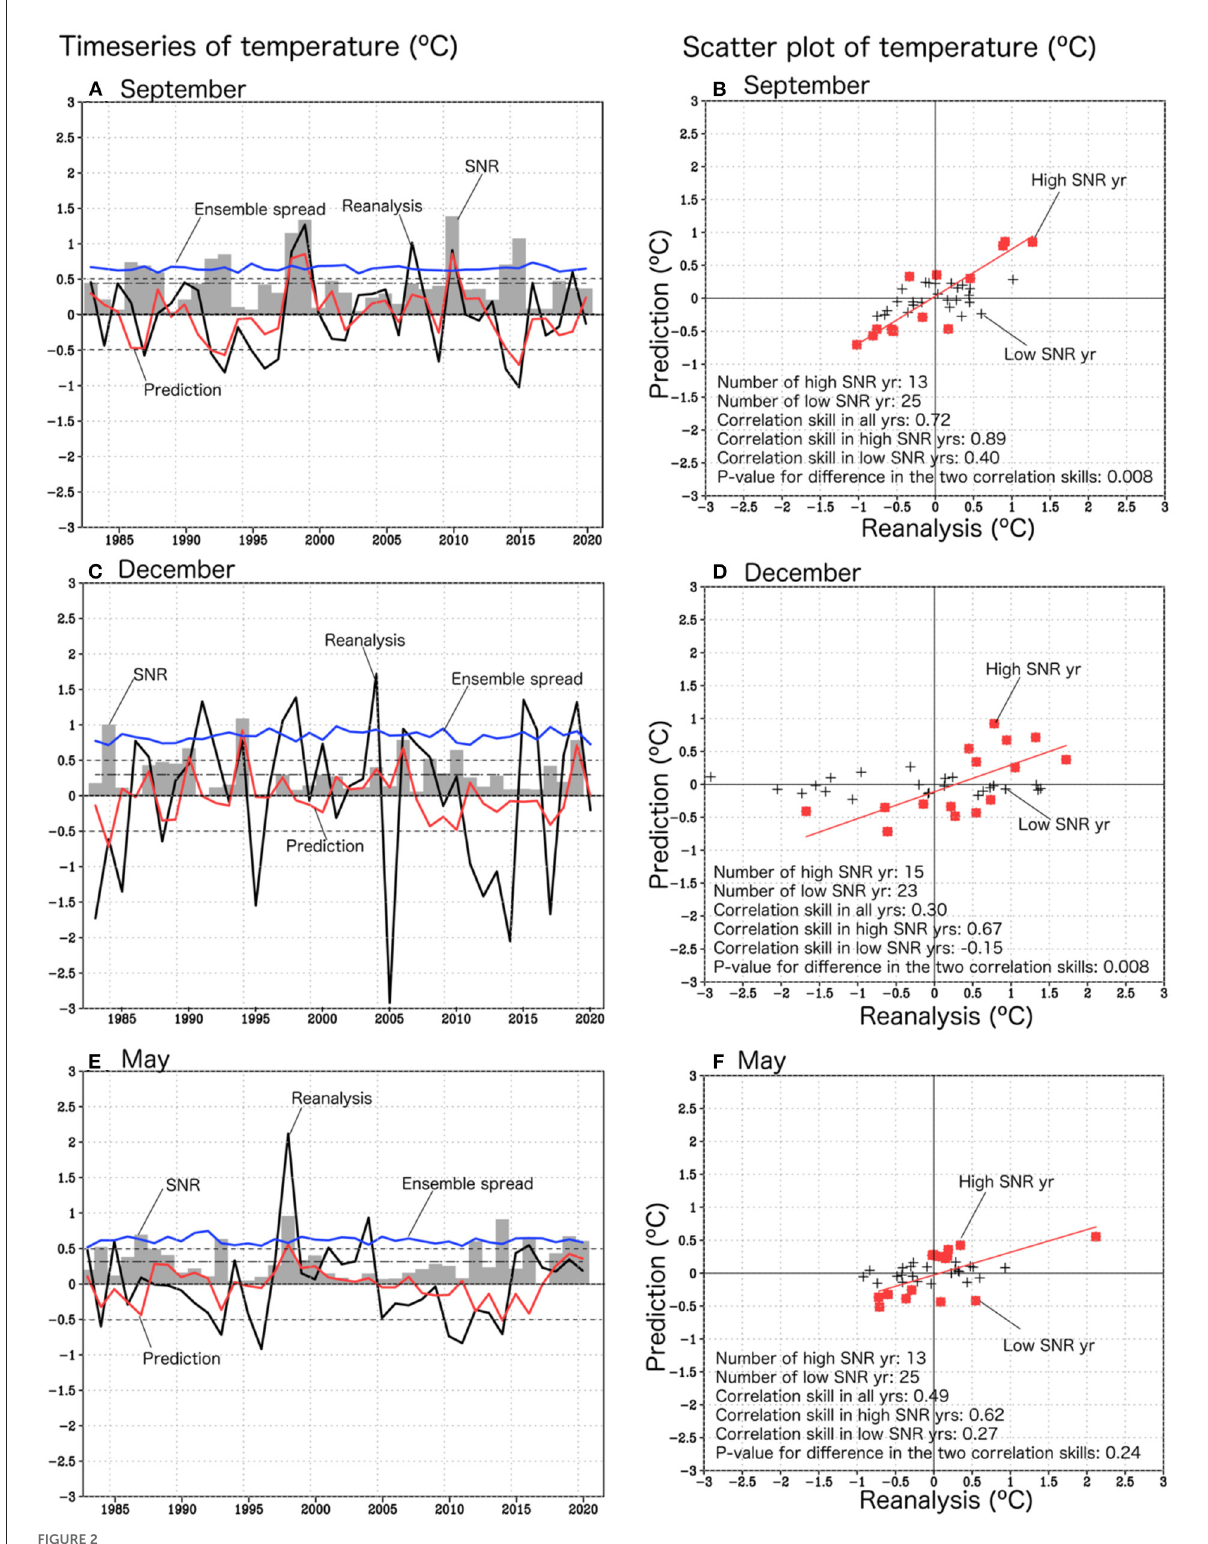
FIGURE2 (A) Interannual time series of September temperature regionally averaged over most part of Japan (129 ◦ E − 141 ◦ E, 30 ◦ N − 37 ◦ N) for 1983–2020 by the reanalysis (black line), the ensemble mean predictions issued on 1st − 9th of August (red line). Interannual variations of the ensemble spread (blue curve), the SNR (grey bars), and the 1983–2020 averaged SNR (chain line) are also shown. (B) Scatter plot of September